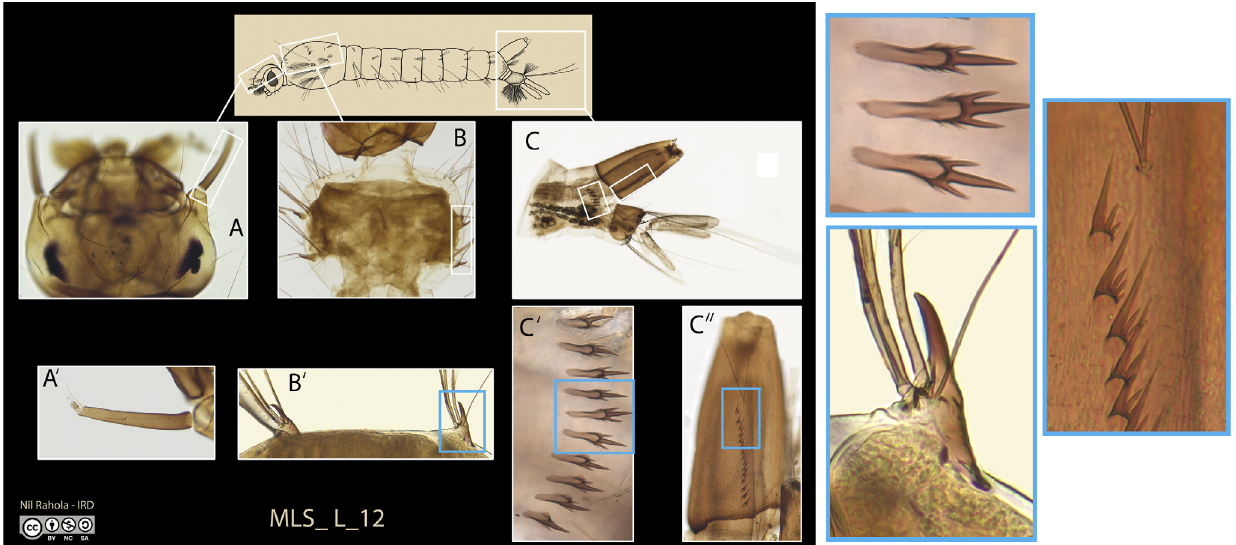
Figure 2. Example of a set of images used for the identi fi cation exercise: plate MLS_L_10 used for larva identi fi cation and magni fi cation showing discriminating characters (boxed in blue) such as head (A) and antenna (A ’ ), thorax (B) with meso and metathorax with long stout spine, pointed and hooked at the tip (B ’ ), abdominal segments VIII-X (C) with comb composed of 10 teeth with a long median spine and strong smaller spines at the basis (C ’ ) and pecten with 15 evenly spaced teeth (C ’’ ). This set of characters is typical of Aedes aegypti